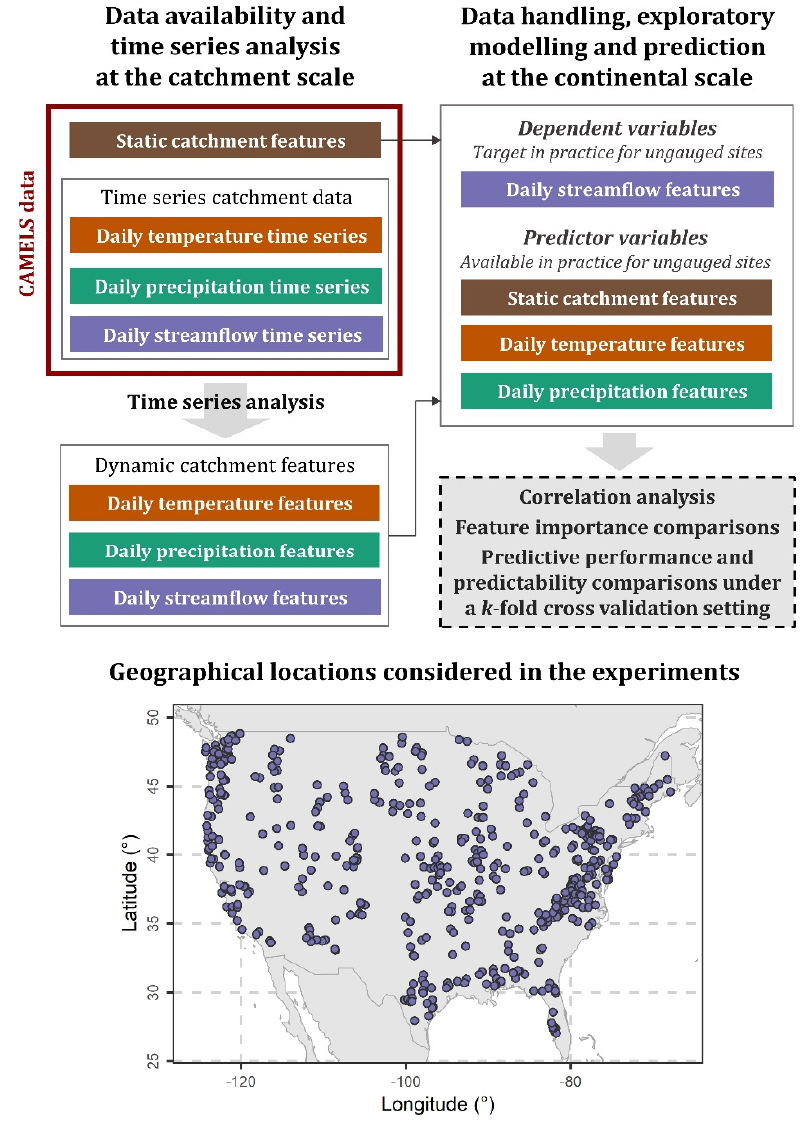
Figure 1. Schematic summarizing the experimental dataset and methodology.